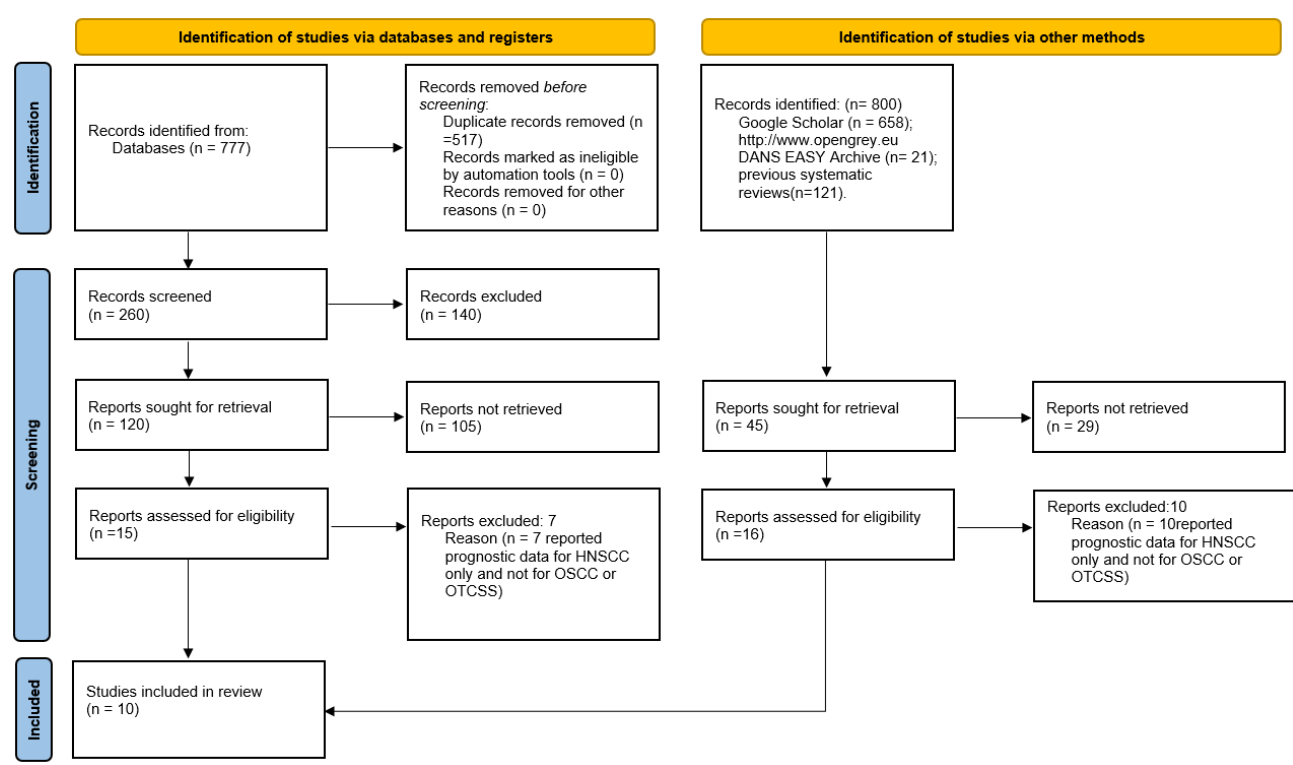
Figure 1. Flowchart of the different phases of the systematic review. Table 1. Main data extracted from the